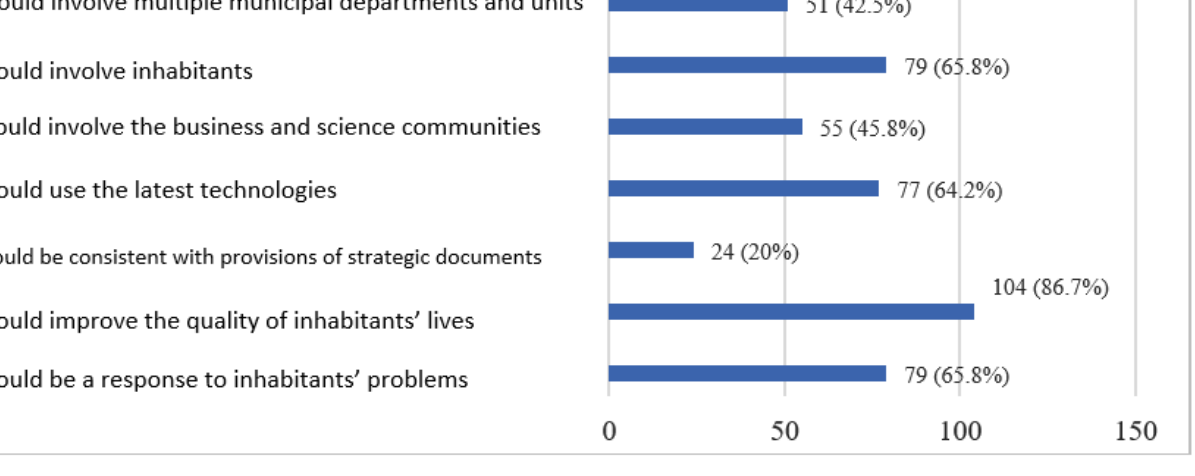
Table 4. The level of inhabitants’ satisfaction with individual functional aspects of the city of Su- wałki.